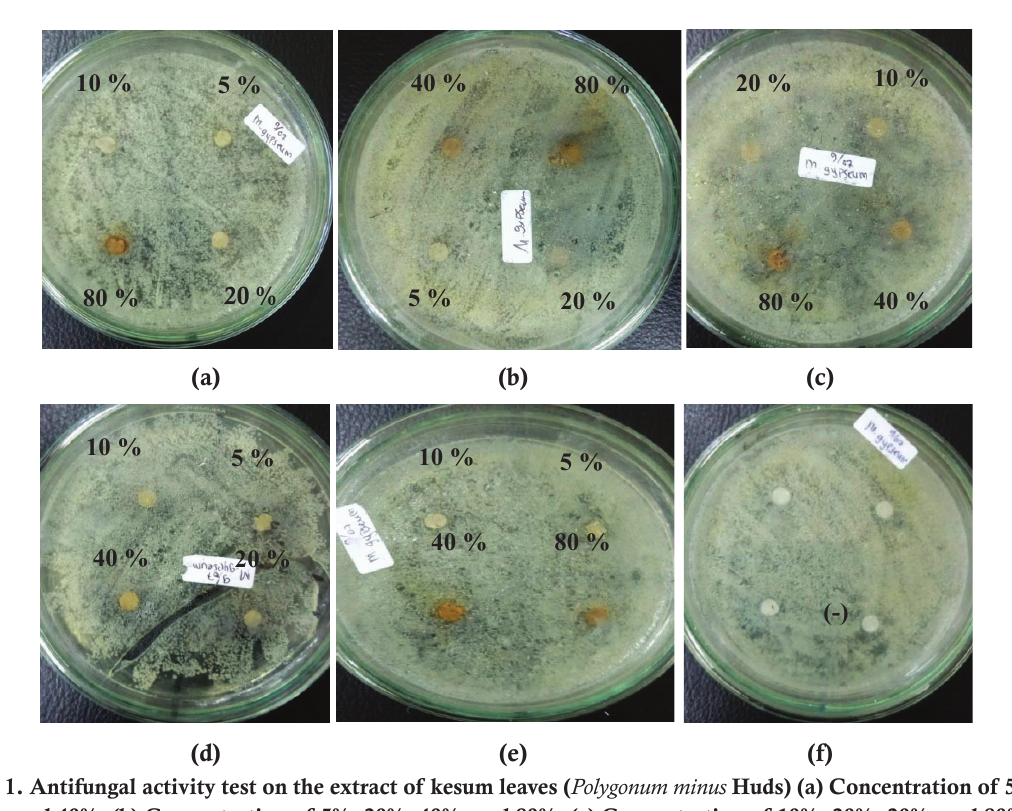
Table 1. Result of phytochemical Analysis